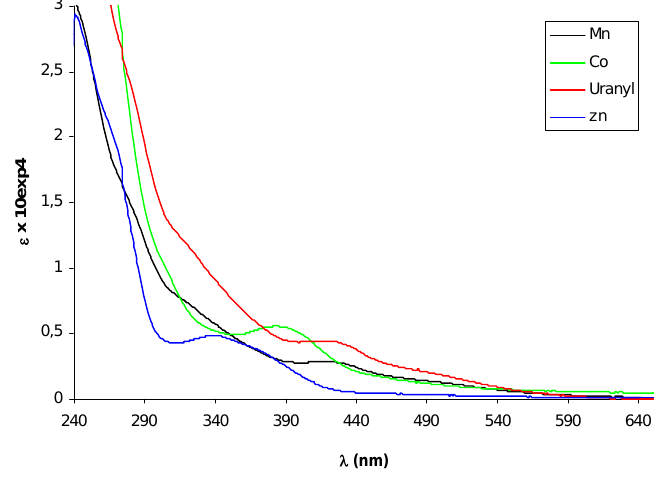
Figure 3. UV-vis spectra of metal complexes of (+)- 9 . The spectrum of Zn(II)-complex , the others in CH was registered in CHCl 3 3